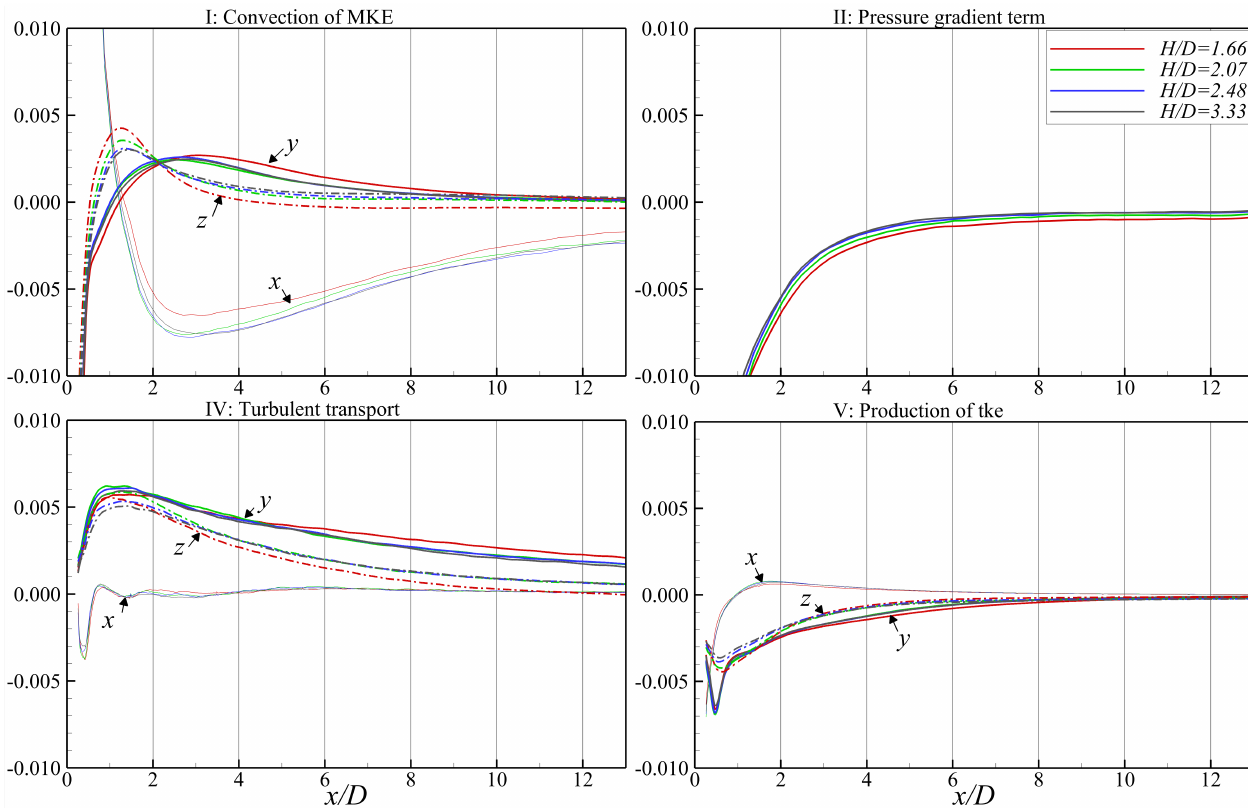
Fig. 6. Streamwise variation of the cross-sectional averaged value of mean kinetic energy equation terms (Eq. 1) in the wake region.